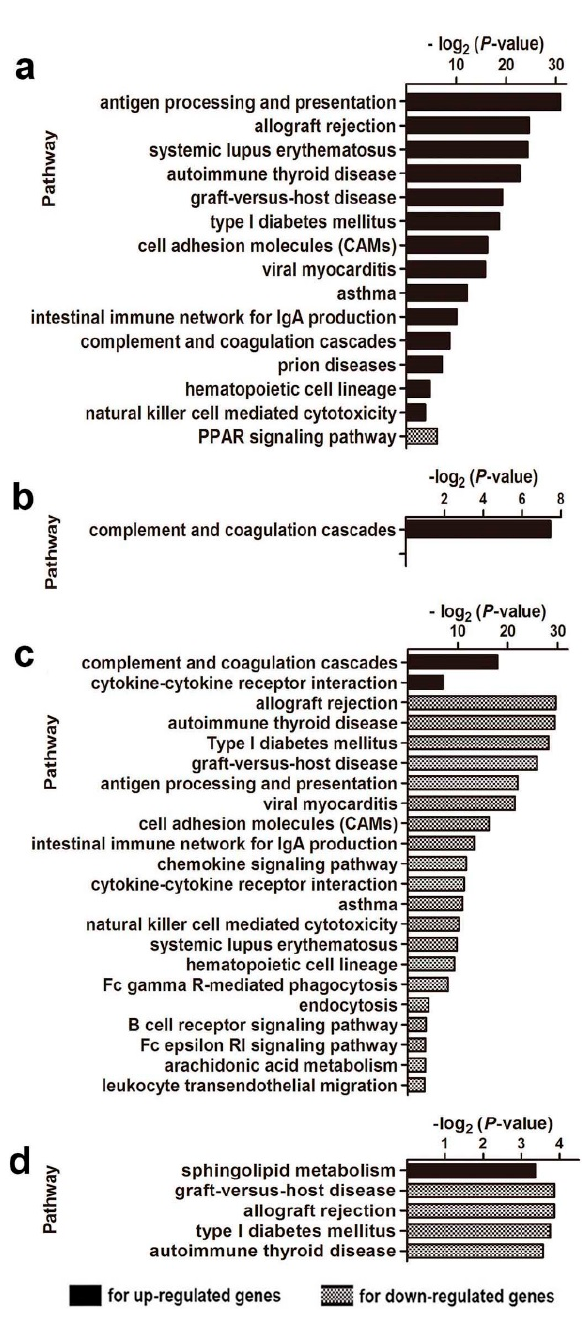
cascades, and natural killer cell mediated cytotoxicity. Downregulated genes ( Adipoq and Plin1 ) were involved in the PPAR signaling pathway.